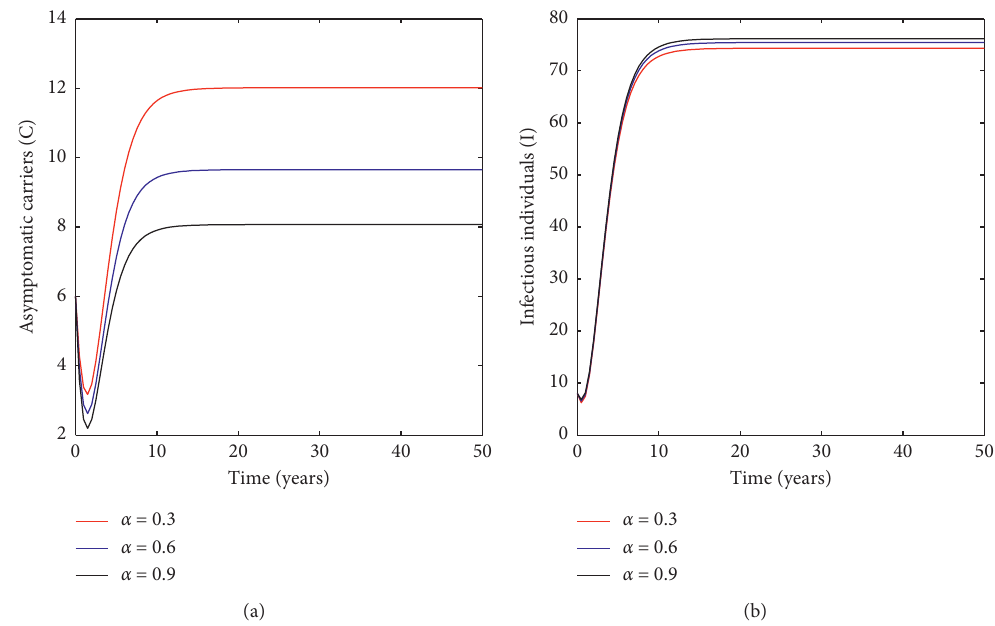
Figure 3: (a, b) Simulation results showing the impact of testing and diagnosis of asymptomatic carriers and symptomatic infectious individuals.